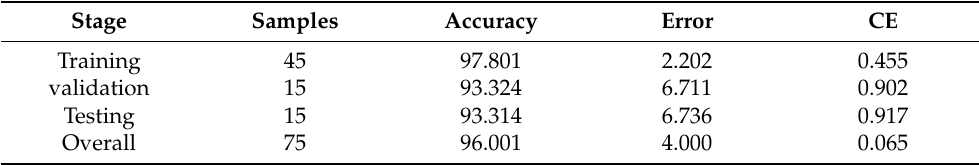
Table 4. Statistical results of the artificial neural network classification models, developed using the e-nose outputs as inputs for the classification of five varieties of potatoes. Abbreviations: CE: means Cross